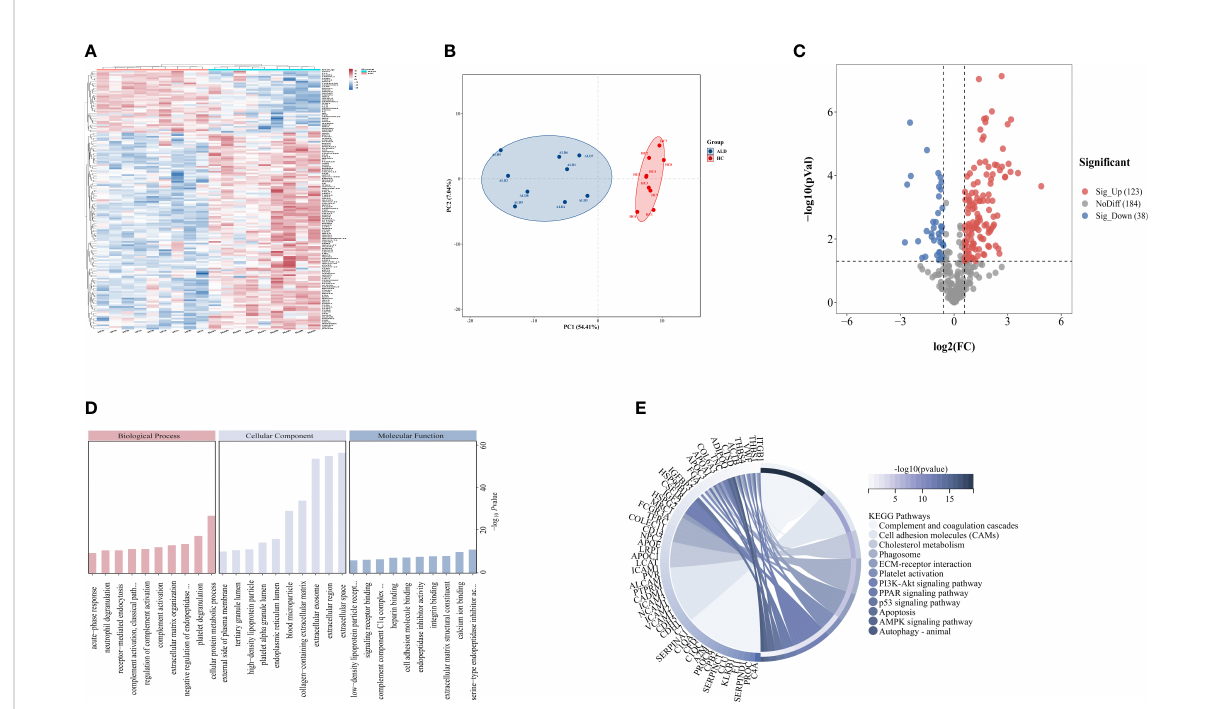
FIGURE 1 Differential expressed proteins of clinical patients. (A) Heatmap represents gene expression trends in HC and ALD groups. (B) PCA shows two dimensionalities of HC and ALD groups according to differential proteins. (C) Volcano plot shows the identi fi ed proteins of HC and ALD groups distribution. (D) GO enrichment shows function and location of differential proteins. (E) KEGG enrichment shows the related pathways with P